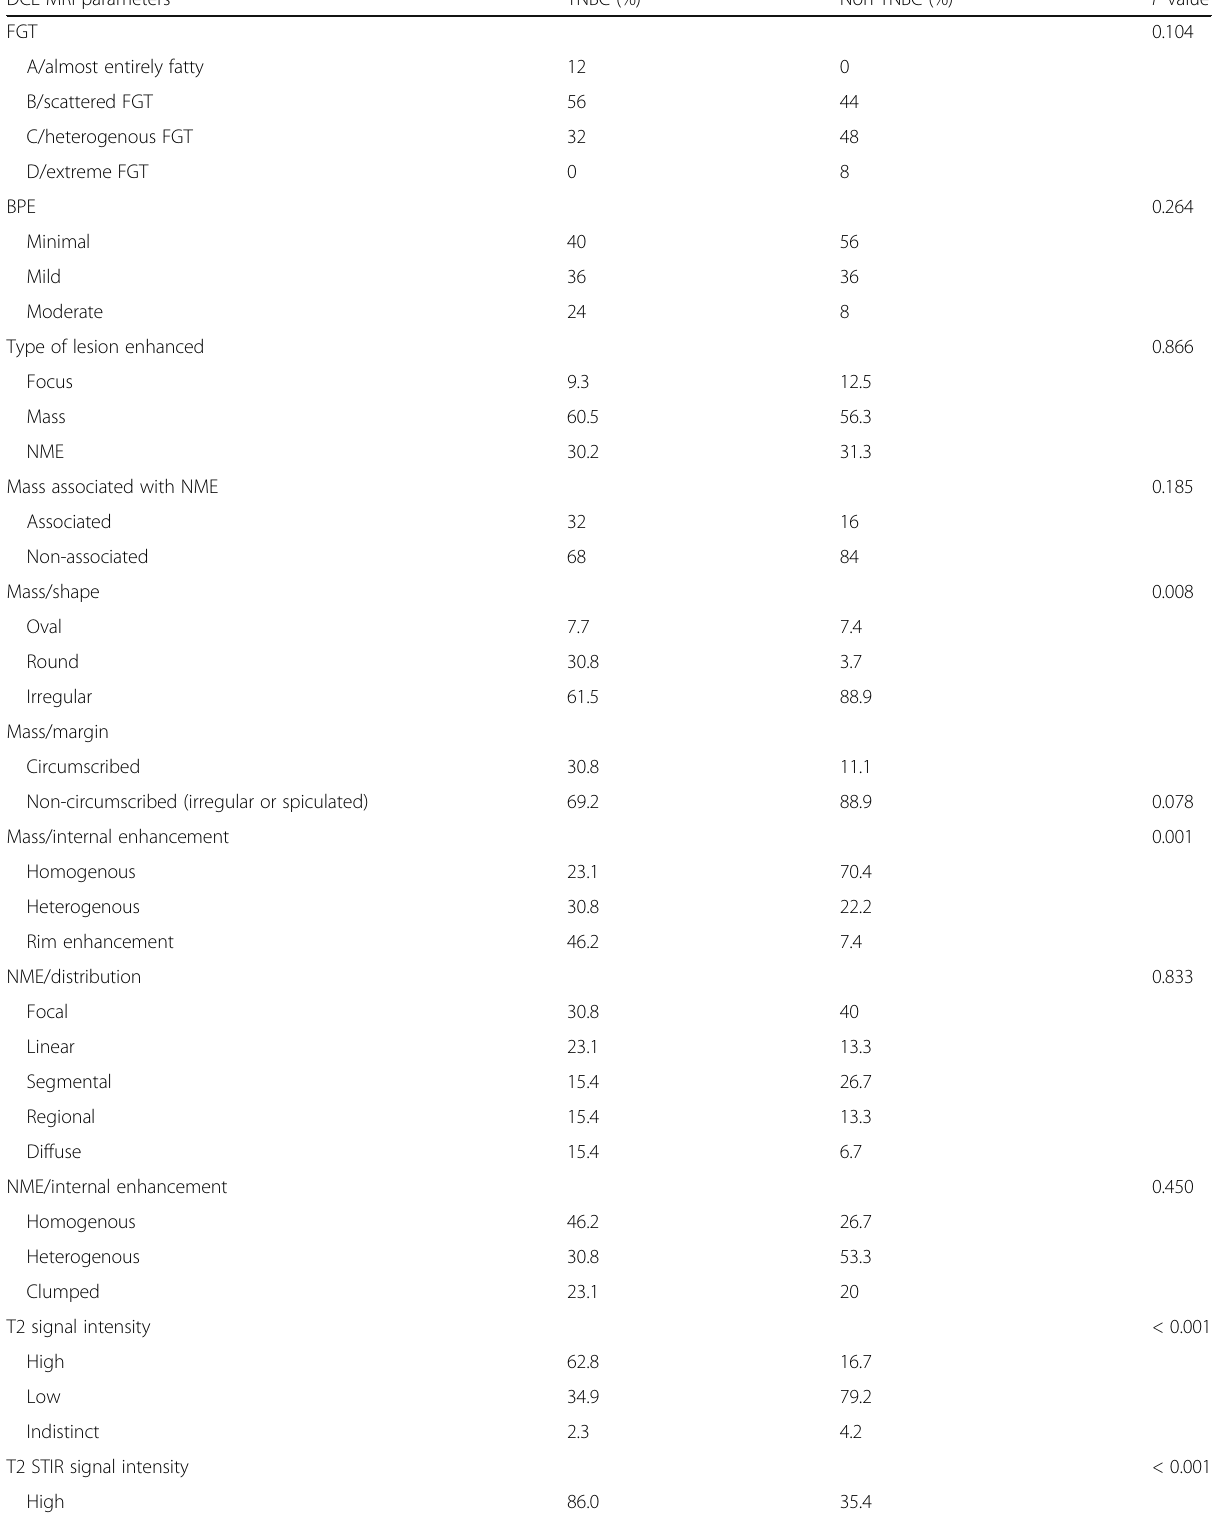
Table 2 DCE-MRI features of TNBC compared to other subtypes of breast cancer